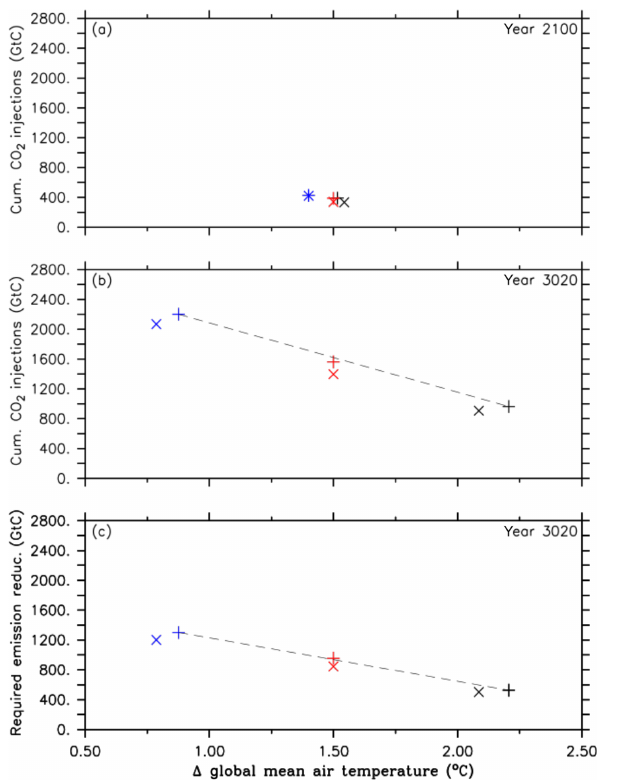
Figure 2. Comparison between simulations of the first approach (A1, black symbols), simulations of the second approach (A2, red symbols) and simulations of the third approach (A3, blue symbols). The cross symbols refer to the default simulations, and the X sym- bols denote simulations with CaCO 3 sediment and weathering feed- backs. These symbols represent (a) cumulative CO 2 injections and their corresponding global mean temperatures, relative to preindus- trial levels, in the year 2100, (b) cumulative CO 2 injections and their corresponding global mean temperatures, relative to preindus- trial levels, at the end of the simulation (in the year 3020), and (c) required emission reduction and its corresponding global mean temperature, relative to preindustrial levels, at the end of the simu- lations. Note that the dashed black lines are eye-fitted to the results of the standard